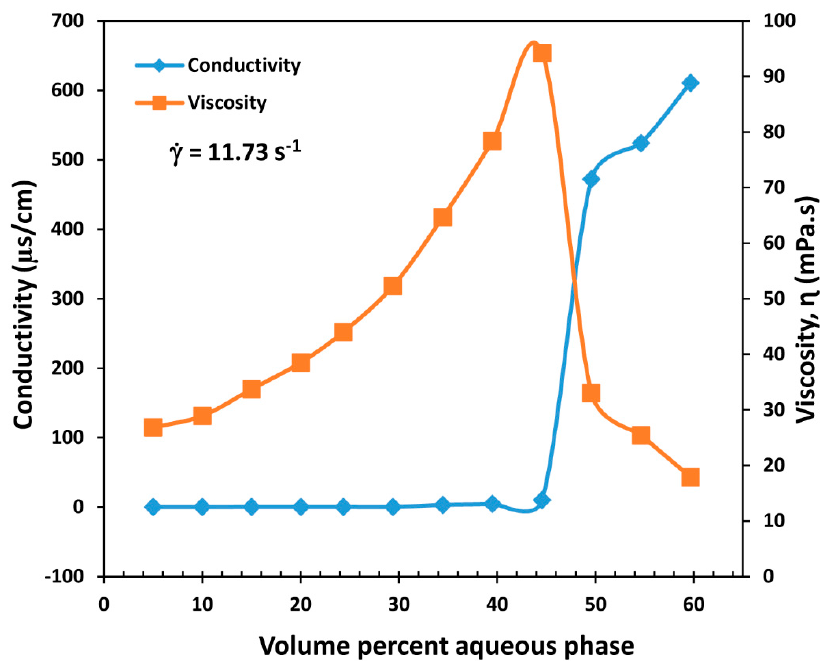
Figure 11. Variations of electrical conductivity and viscosity of emulsion with the increase in aqueous-phase concentration. SNP concentration of aqueous phase is 0.50% wt.